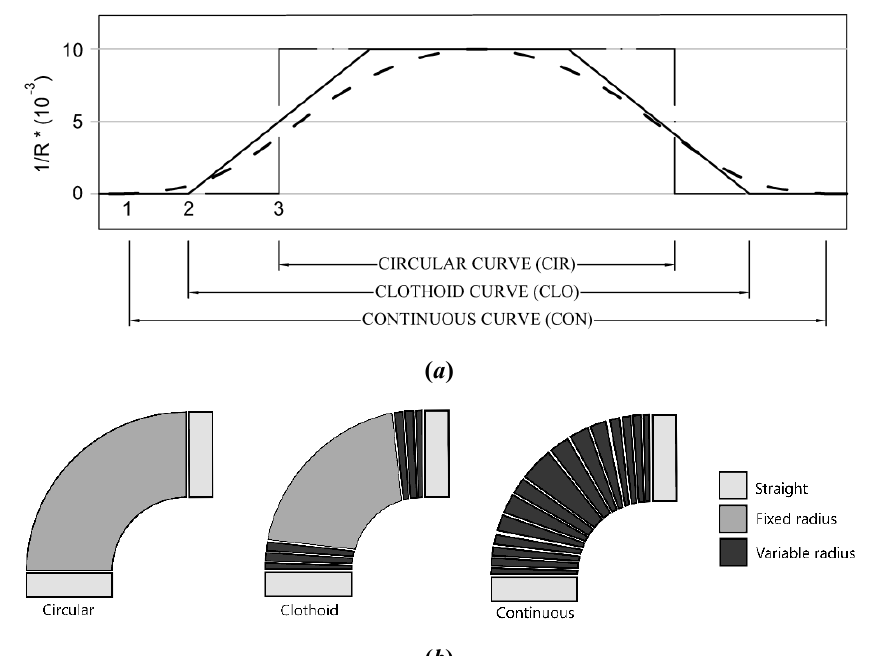
Figure 3 Differences between the three curves evaluated in this experiment: ( a ) The lengths of the curves. The starting points are, respectively, indicated with a 1 for the Continuous Polynomial curve (CON), with 2 for the Clothoid (CLO) and with 3 for the Circular curve (CIR). The y-axis represents the curvature (1 / R ) where R is the radius of the curve. ( b ) A simplification of the three types of curves, illustrating which parts have a fixed and which a variable radius. The circular curve has a fixed radius from start to end (left), the Clothoid curve has a changing radius at the beginning and end of the curve (middle), the continuous curve has a changing radius through the entire curve